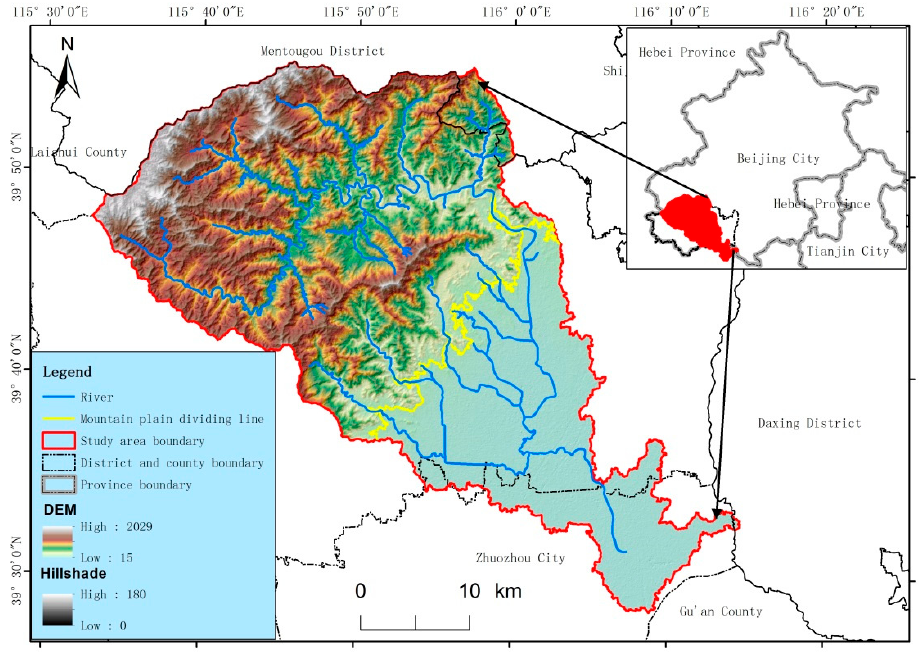
Figure 1. Location of study area and Dashi Watershed.